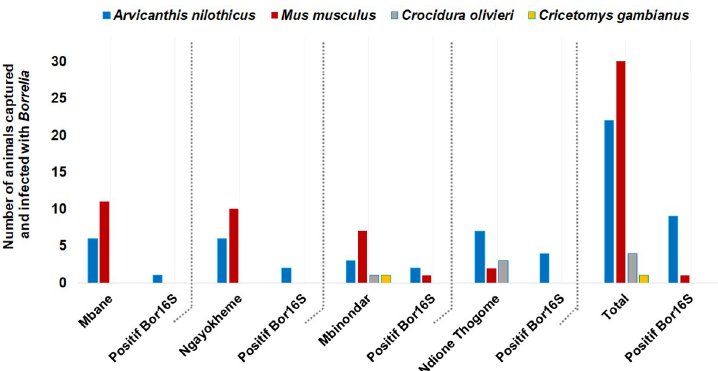
Fig 7. Numbers of animals captured and the prevalence of Borrelia infection in small mammals studied in the Niakhar district.